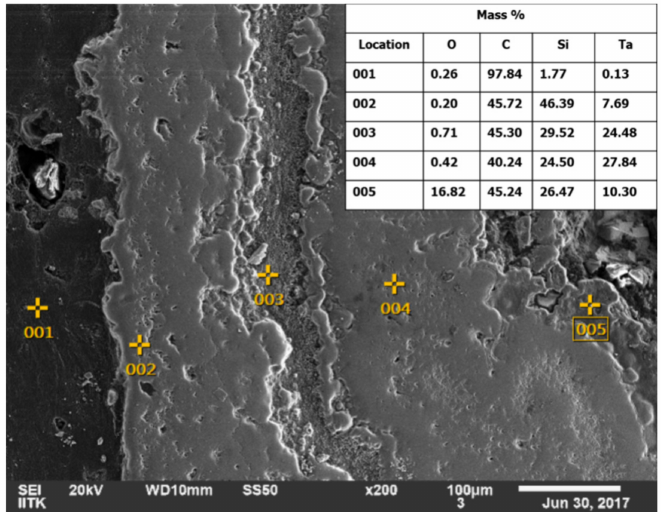
Figure 6. Along the thickness chemical composition of the coating after the ablation